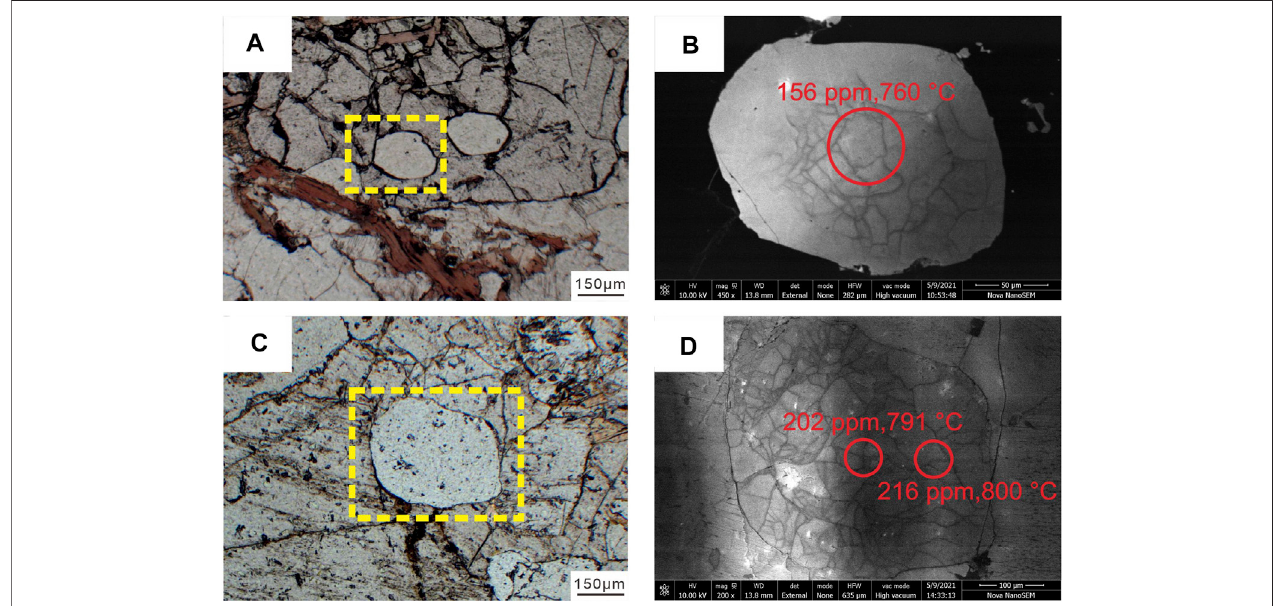
FIGURE9| RepresentativephotomicrographsandCLimagesoftheanalyzedquartzgrainsshowingreticularstructure. (A) Quartzinclusionwithingarnetinsample 20HL59 and CL image is shown in (B) ; (C) Matrix-type quartz in sample 20HL89 and CL image is shown in (D) .